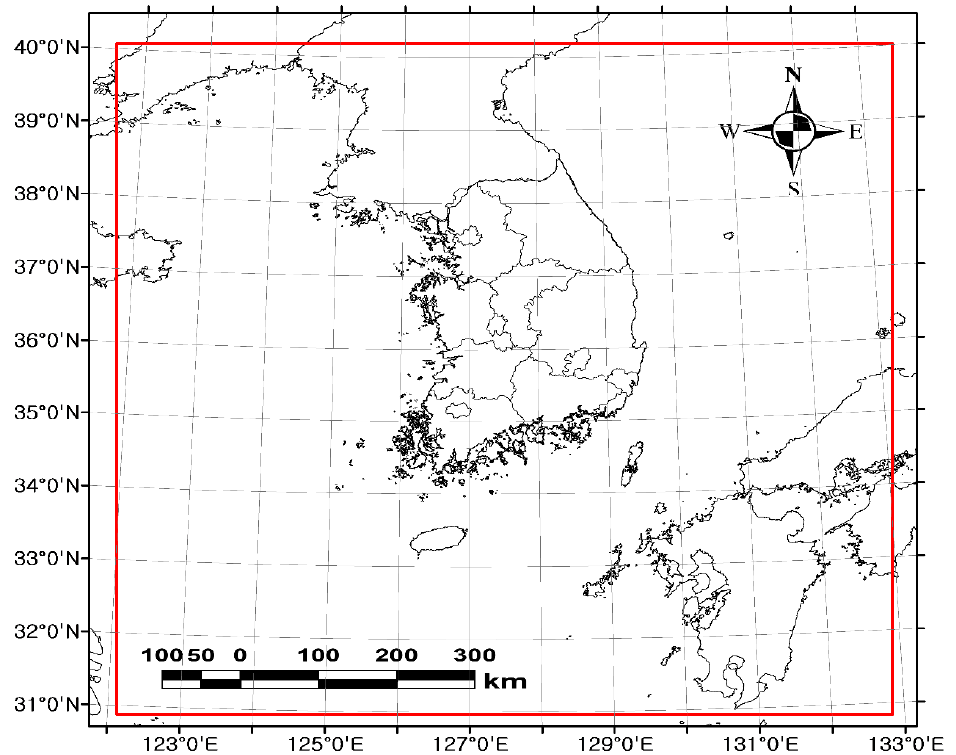
Figure 1. The entire domain of MAPLE forecast (red-lined box), with 60 min lead time forecast generated at 01:00 5 July 2016. MAPLE: McGill Algorithm for Precipitation Nowcasting by Lagrangian Extrapolation.